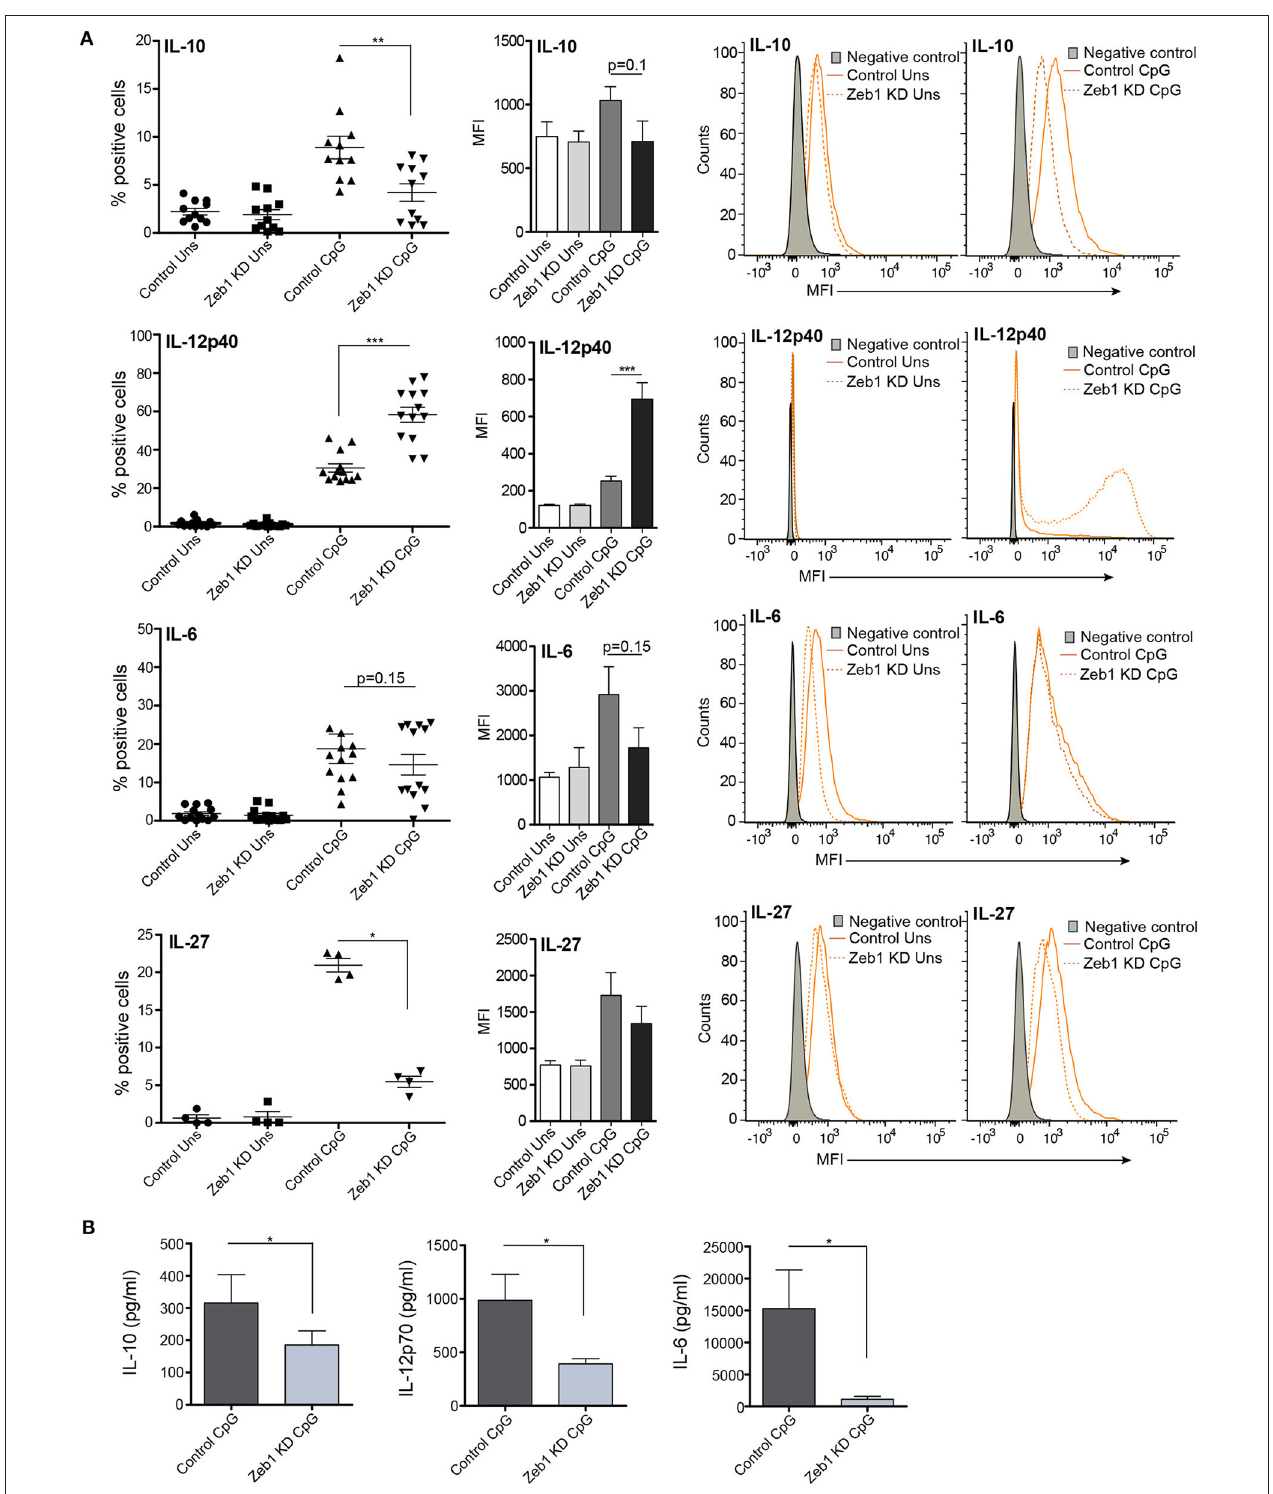
FIGURE 2 | EMT factor Zeb1 KD suppresses expression of important DC response cytokines in cDC1 MutuDCs. (A) Scatter-plots showing the percentage positive cells for intracellular cytokines IL-10, IL-12p40, IL-6, and IL-27 in Zeb1 KD cDC1 MutuDCs compared to control cells before and after 12h CpG activation. The corresponding bar plots and representative histograms in each panel depicting the MFI shifts for these cytokines in Zeb1 KD as compared to control DCs n = 8–12. (B) Bar-plots demonstrating the Bio-plex based quantitation of IL-10, IL-12p70, and IL-6 cytokines secreted in the supernatants of 12h CpG activated Zeb1 KD and control DCs n = 5. p -values are calculated using two tailed unpaired student’s t -test, error bars represent SEM. * ≤ 0.05, ** ≤ 0.01, *** ≤ 0.001.